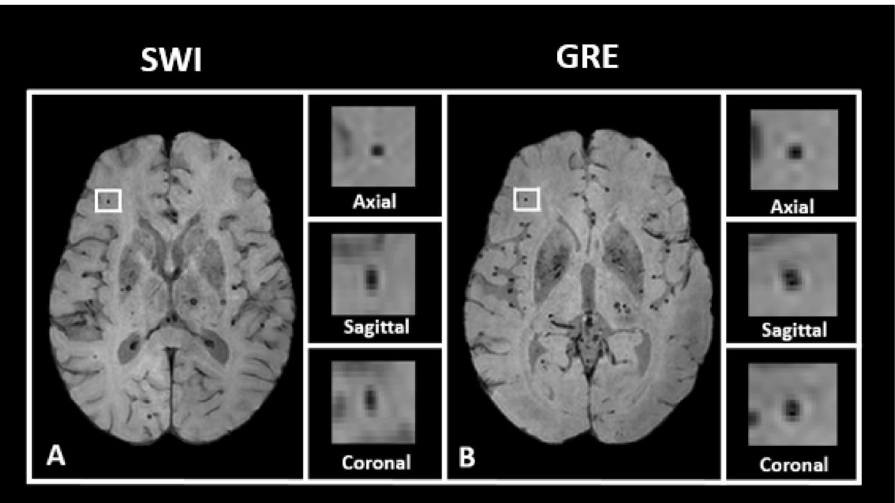
Figure 1. Examples of microbleed location. The participant’s MRI shown here reflects a heavy burden of cerebrovascular disease. ( A) Left: axial slice of a SWI image, with a microbleed location highlighted in white. Right: an enlarged image of the highlighted location. From top to bottom, the views shown are axial, sagittal, and coronal. ( B) Left: axial slice of the same participant’s GRE image, with the same microbleed location highlighted in white. Right: an enlarged image of the highlighted location. From top to bottom, the views shown are axial, sagittal, and